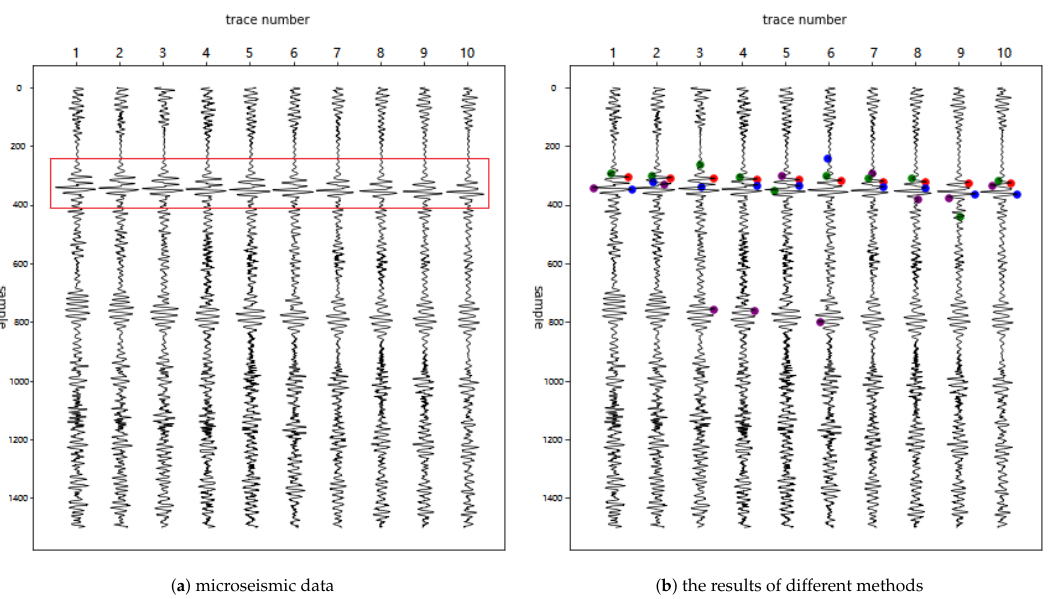
Figure 5. First arrivals picked by FPSF for field microseismic record. ( a ) field microseismic record; ( b ) the result of different methods: MCM (purple), BNN (blue), DC (green), FPSF (red).